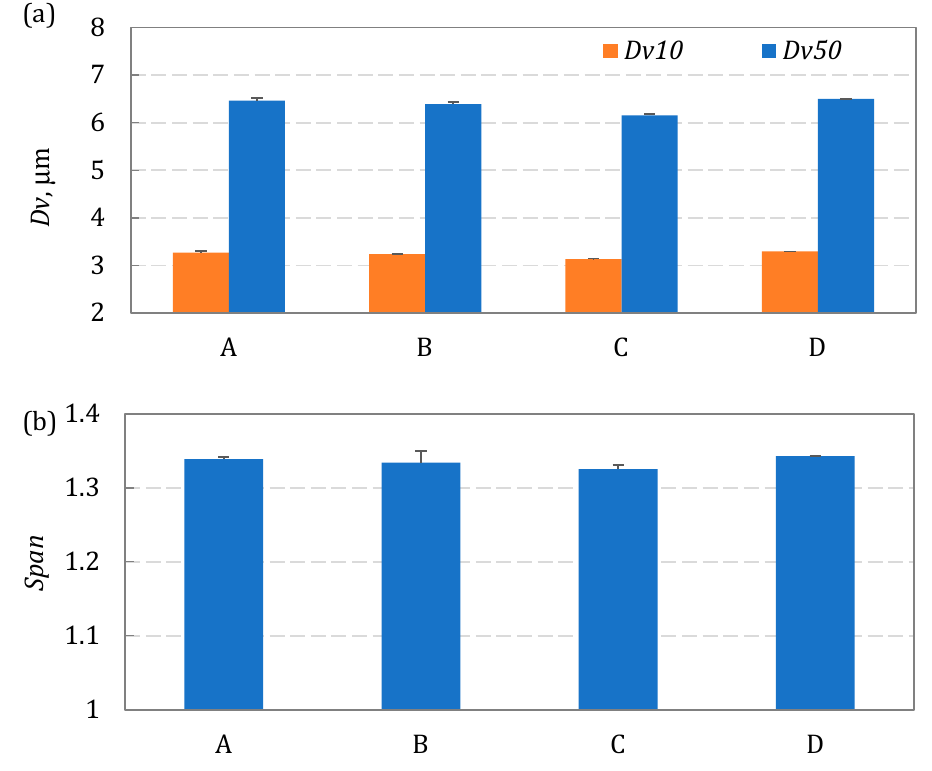
Figure 10. ( a ) Volumetric median diameter, Dv50, and volumetric diameter Dv10 of emitted droplets. ( b ) Span of the distribution. Error bars show the standard deviation ( n = 3).